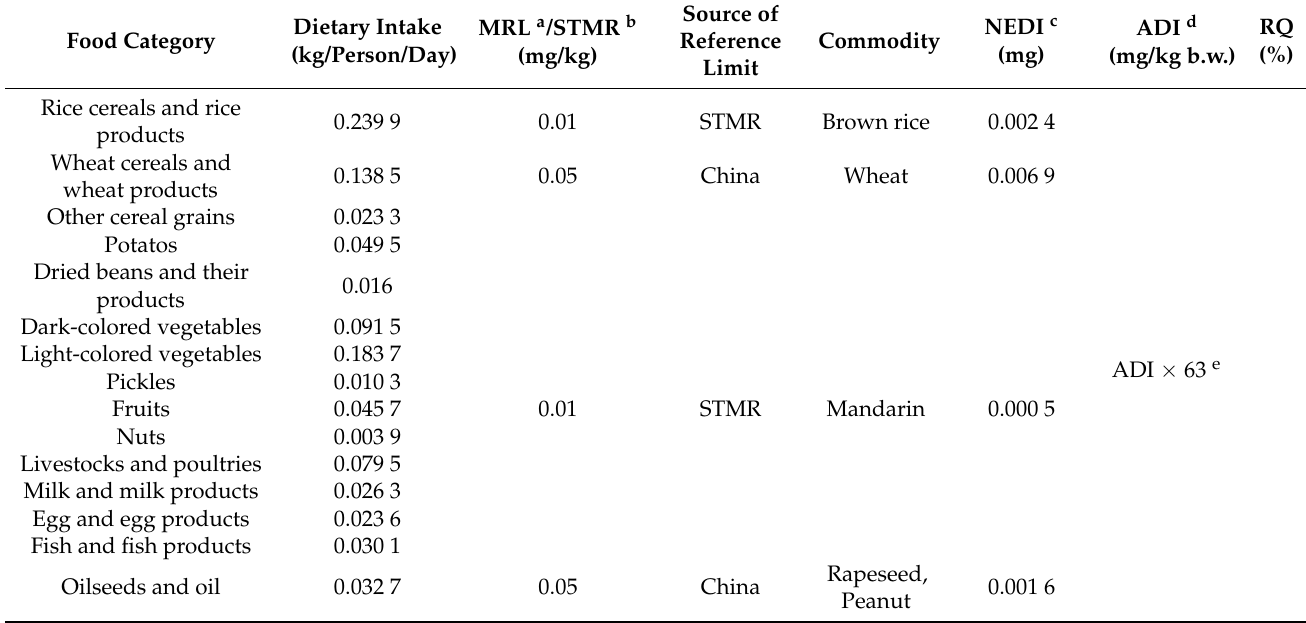
Table 4. The long-term dietary risk assessment of uniconazole based on Chinese food